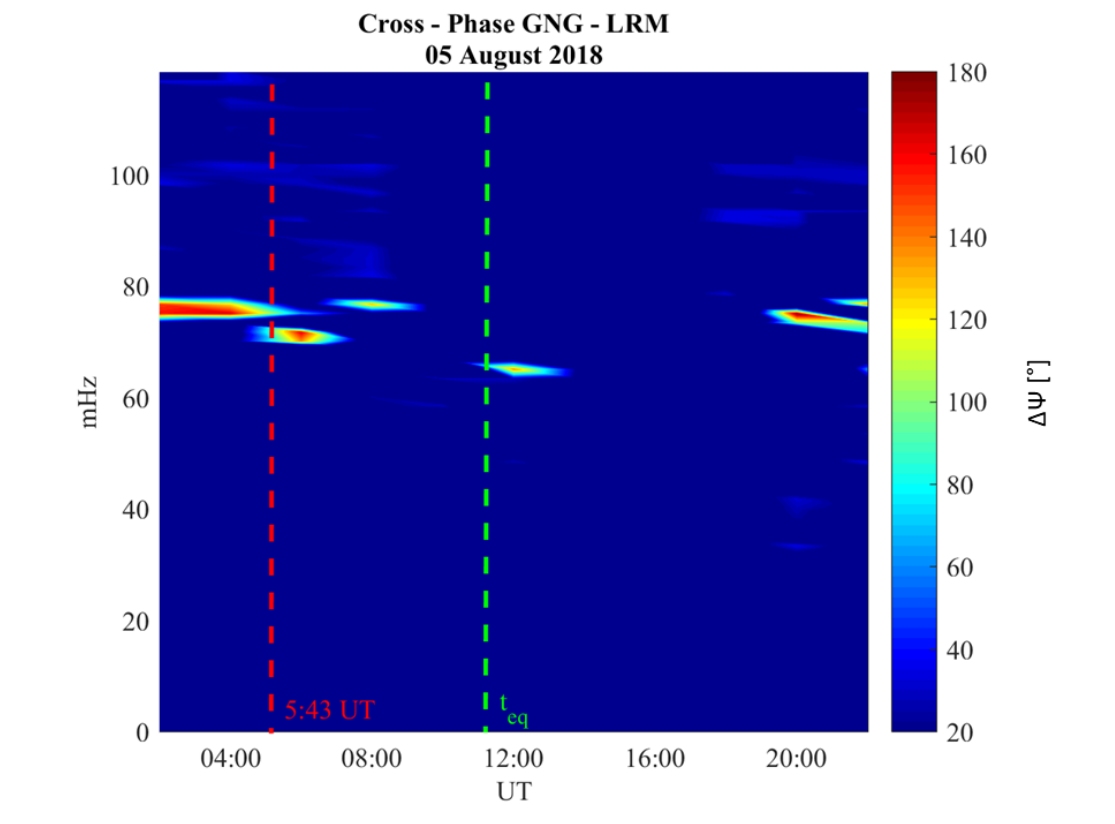
Figure 4. The cross-phase dynamical spectrogram between two low-latitude ground stations near the earthquake epicenter (GNG-LRM; GNG: λ = 31.36 ◦ S and φ = 115.71 ◦ E; LRM: λ = 22.22 ◦ S and φ = 114.1 ◦ E). Each spectrum has been evaluated over a 1 h interval. Spectra have been smoothed both in time and frequency domains (7 frequency bands and 15 temporal bands). The green vertical line represents the earthquake occurrence time. The red vertical line represents the occurrence time of the first FLR frequency decrease. ∆ ψ in the color-bar represents the phase difference in degrees between the equatorward (LRM) and poleward (GNG) ground